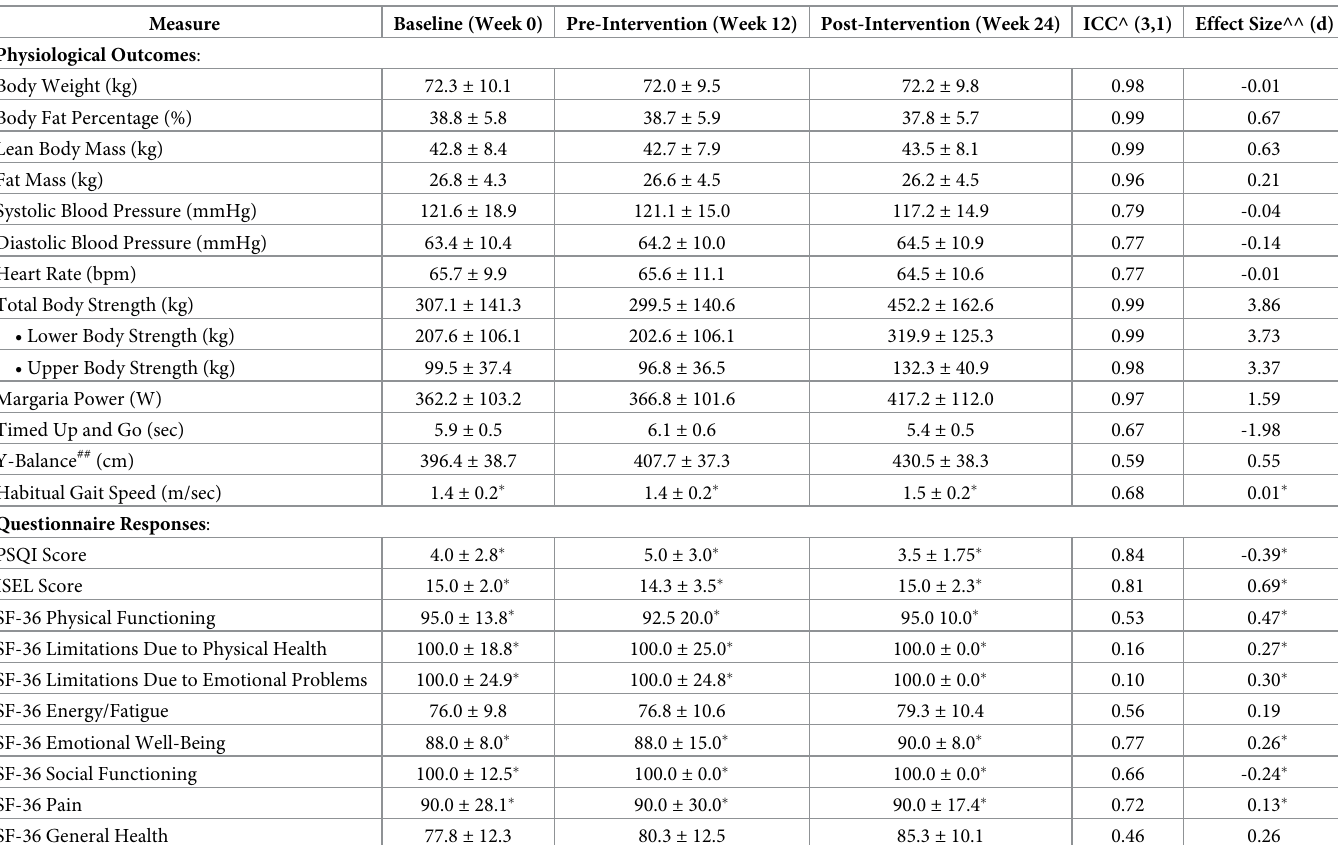
Table 4. Descriptive statistics for physiological outcomes and questionnaire responses at baseline, pre-intervention, and post-intervention (N = 20).